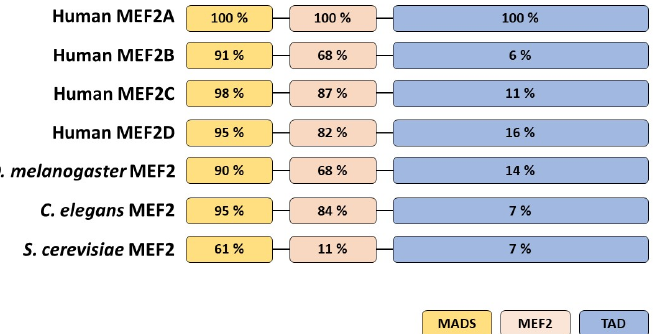
Figure 1. Domain homology of the MEF2 transcription factors family across different organisms. The percentage of sequence identity in relation to human MEF2A taken as 100%. The N-terminus is on the left. MADS — MCM1, AGAMOUS, DEFICIENS and SRF, serum response factor domain; MEF2 — myocyte enhancer factor 2 domain; TAD — topologically associated domain. Adapted from [32].